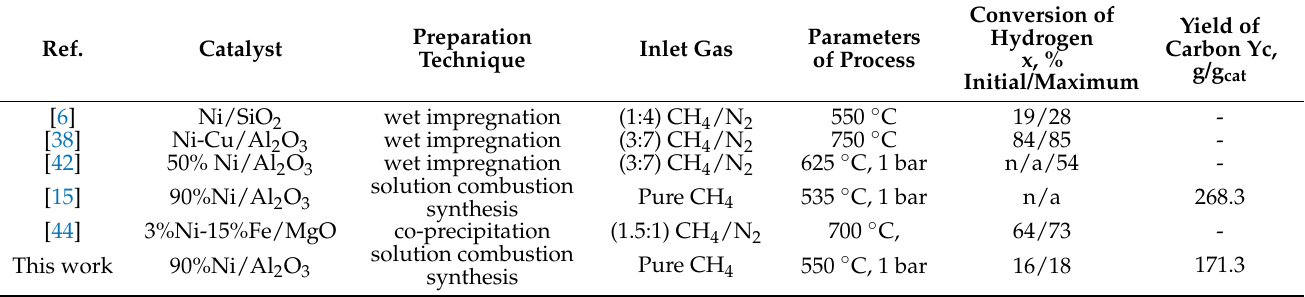
Table 4. A comparison of data reported for various catalysts used for methane decomposition and their efficiency in terms of formation of carbon and